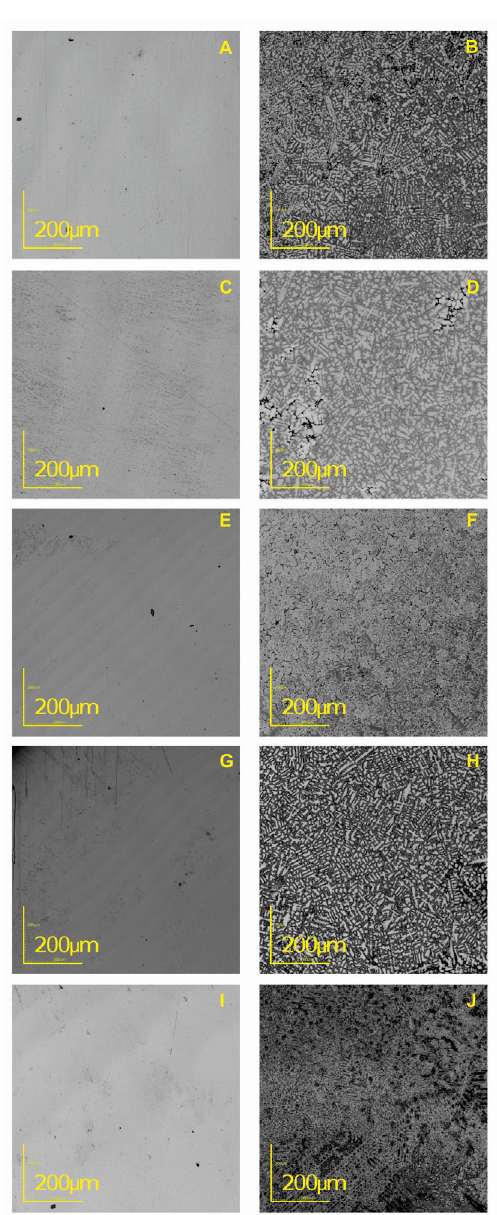
Figure 3. Representative micrographs of corrosion superficial. A) Co-Cr before Fusayama’s saliva; B) Co-Cr after Fusayama’s saliva; C) Co-Cr before Listerine® alcohol-containing; D) Co-Cr after Listerine® alcohol-containing; E) Co-Cr before Listerine®